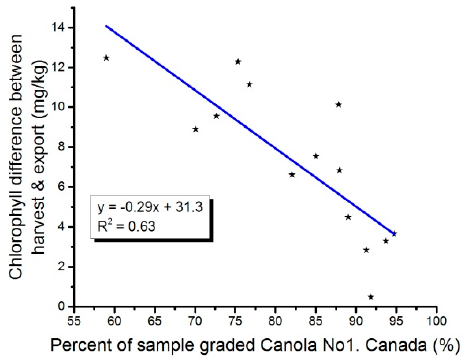
Figure 4. Difference between harvest and export chlorophyll averages versus the percent of harvest samples graded Canada No. 1, Canola.